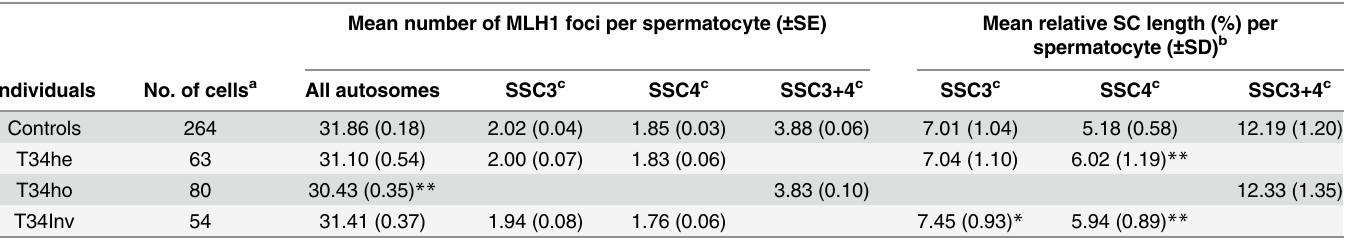
Table 1. Number of spermatocytes analyzed, mean MLH1 foci numbers and relative SC length per spermatocyte.